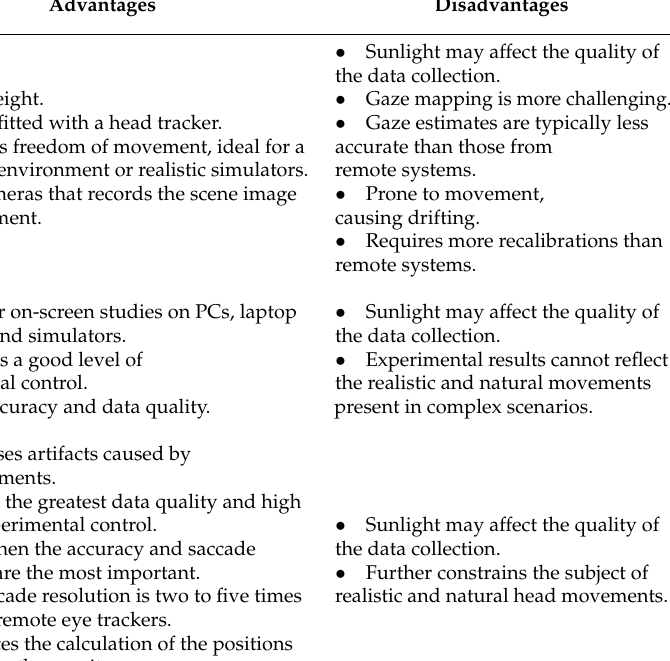
Table 5. Advantages, disadvantages, and ideal applications of video-based eye tracking system types [122,156]. Eye Tracking Device